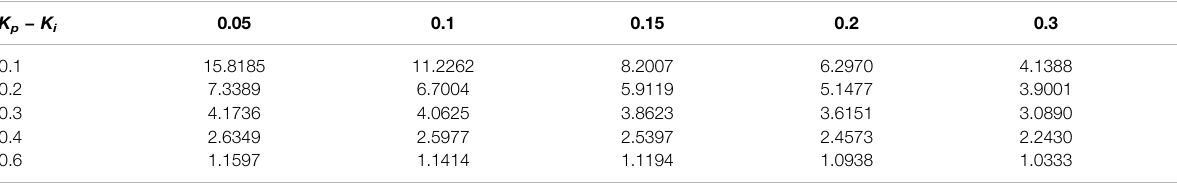
TABLE 3 | Delay margins for K d (cid:2) 0.